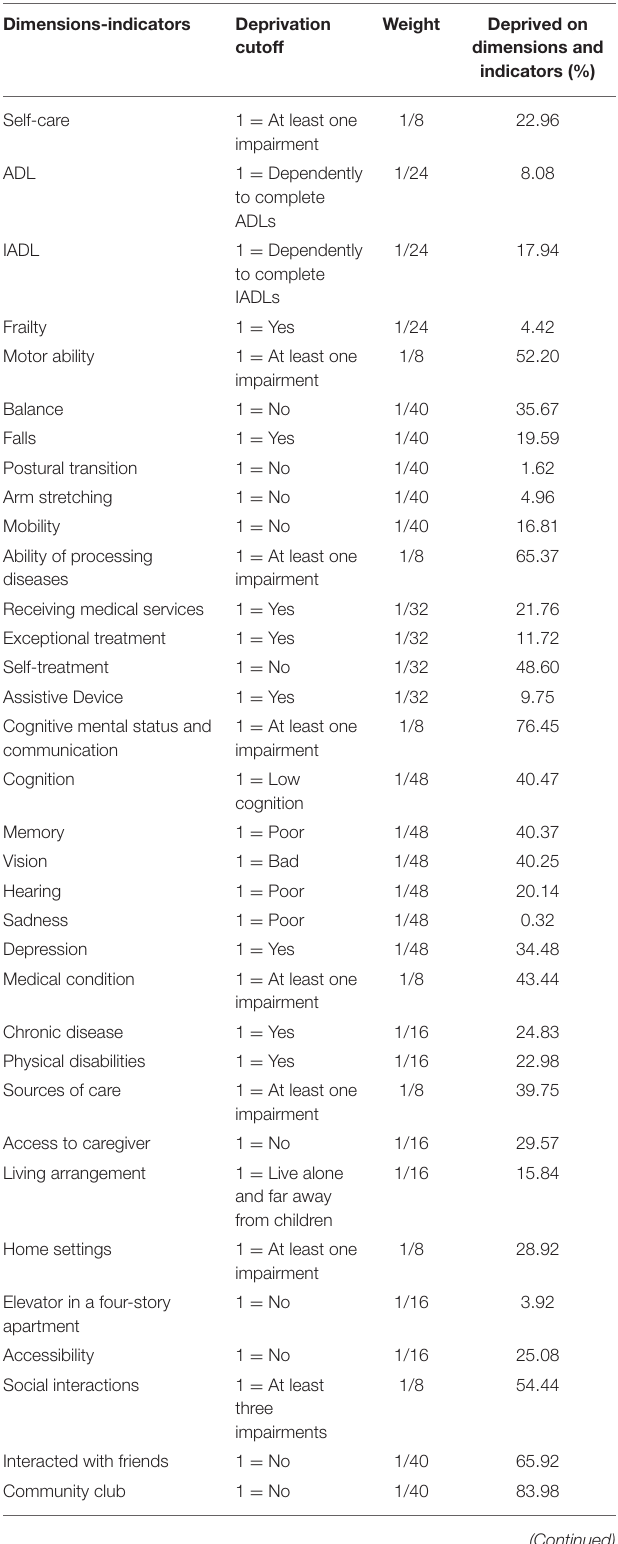
TABLE 7 | Dimensions and indicators of the multidimensional disability and its cut-off after adjustment.